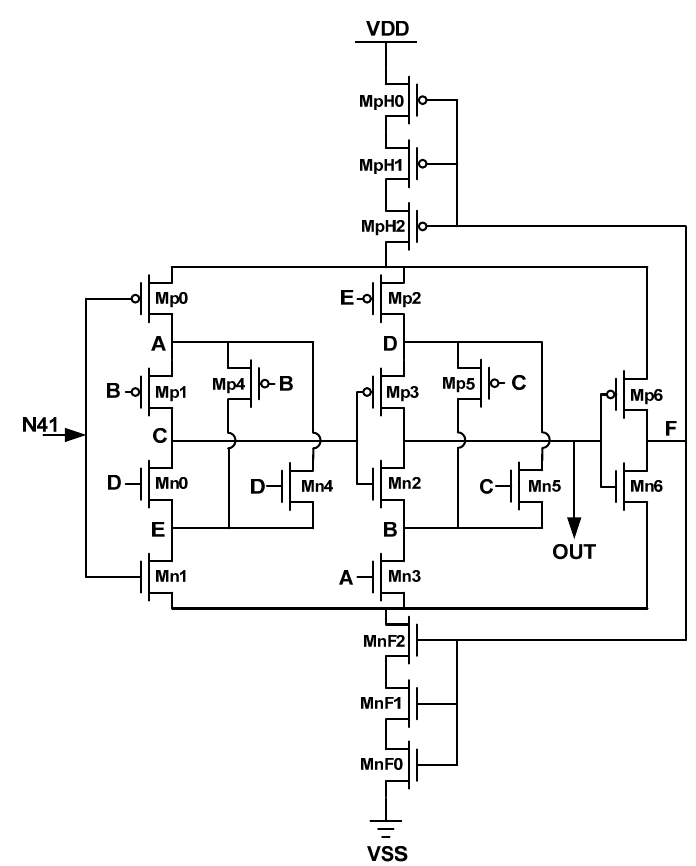
Figure 4. The circuit diagrams of the short hysteresis delay cell (SHDC).